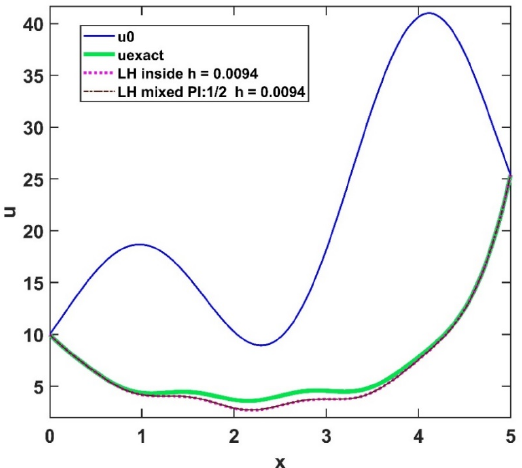
Figure 3. The temperature u vs. the x variable in the case of Experiment 1 for the initial function u 0 , the reference solution at t fin , and the LH method for h = 2 · 10 − 3 when the convection term is inside the numerator, and when it is implemented in a mixed way.